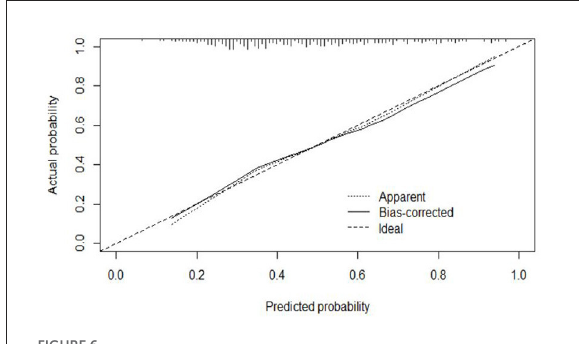
FIGURE6 Calibration curve for the internal verification set.